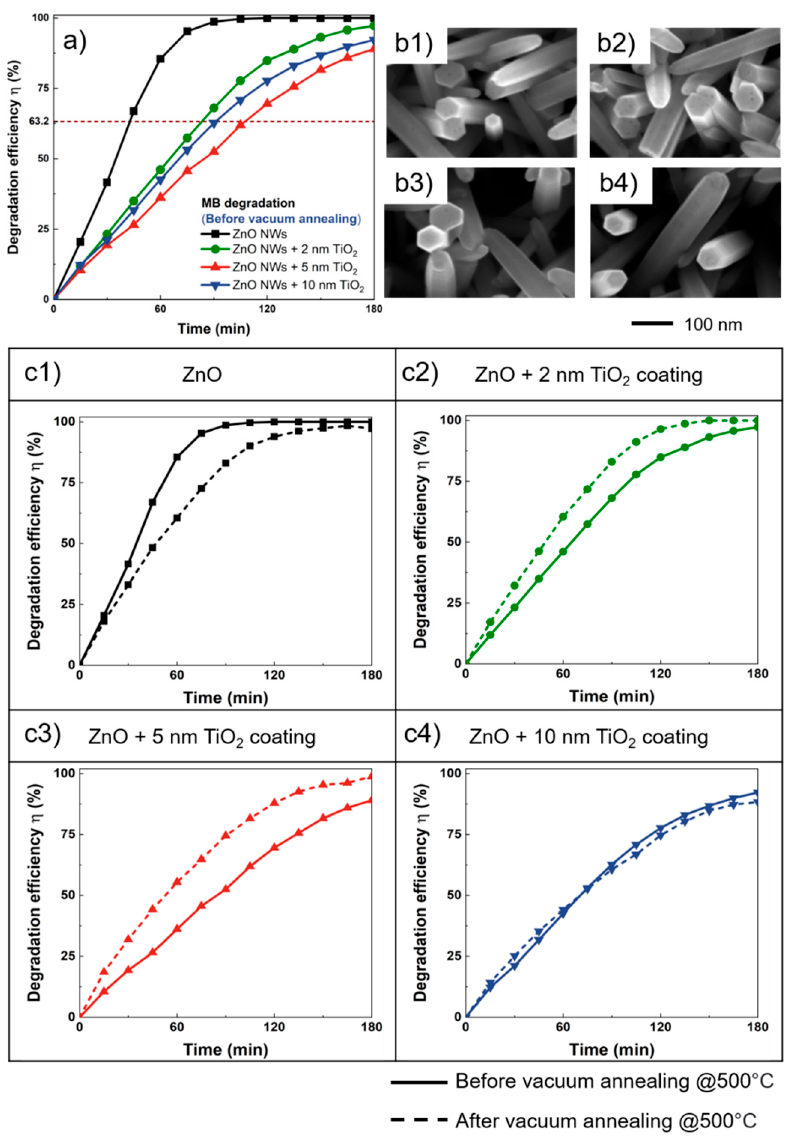
Figure 4. ( a ) Comparison of the photodegradation efficiency of MB among the different TiO 2 coating thicknesses from 0 to 10 nm. ( b ) The SEM photos of the ZnO NWs before ( b1 ) and after vacuum-annealing ( b2 ), 2 nm TiO 2 -coated ZnO NWs before ( b3 ) and after vacuum-annealing ( b4 ). ( c1 – c4 ) Comparison of photodegradation efficiency of different samples before and after vacuum-annealing.